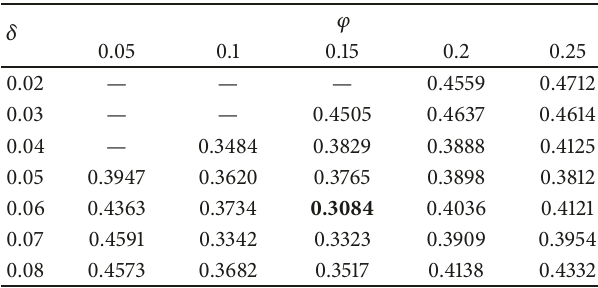
Table 1: TheRMSE of theILES with different parameters Δ,Φ (𝑇 푘 = 7)